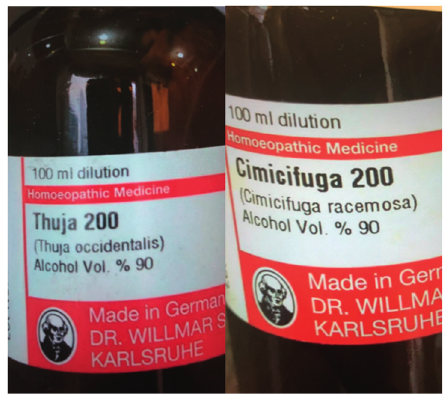
Figure 1: Patient’s medication